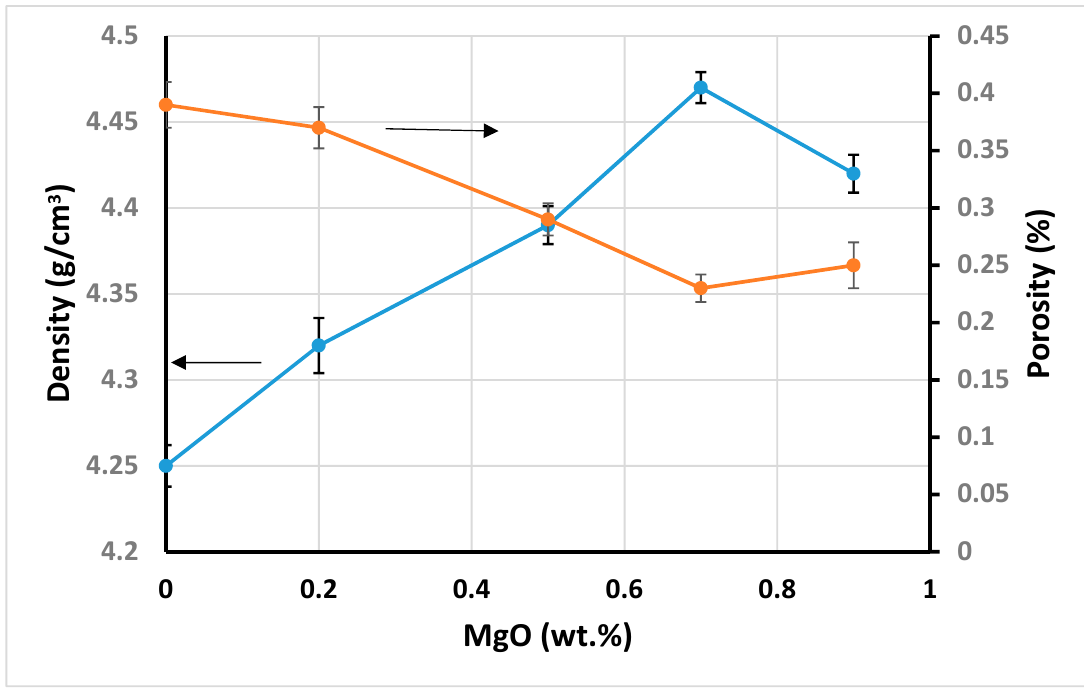
Figure 3. Microstructure of ZTA-MgO samples. ( a ) 0.2 wt.% MgO, ( b ) 0.5 wt.% MgO, ( c ) 0.7 wt.% MgO, and ( d ) 0.9 wt.% MgO.